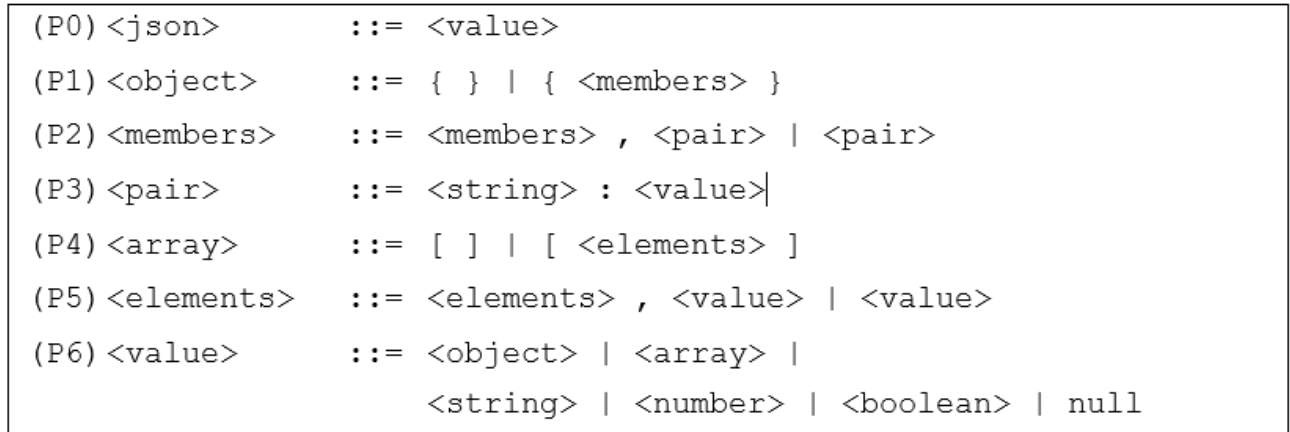
Figure 4. The BNF syntax of the JSON language.